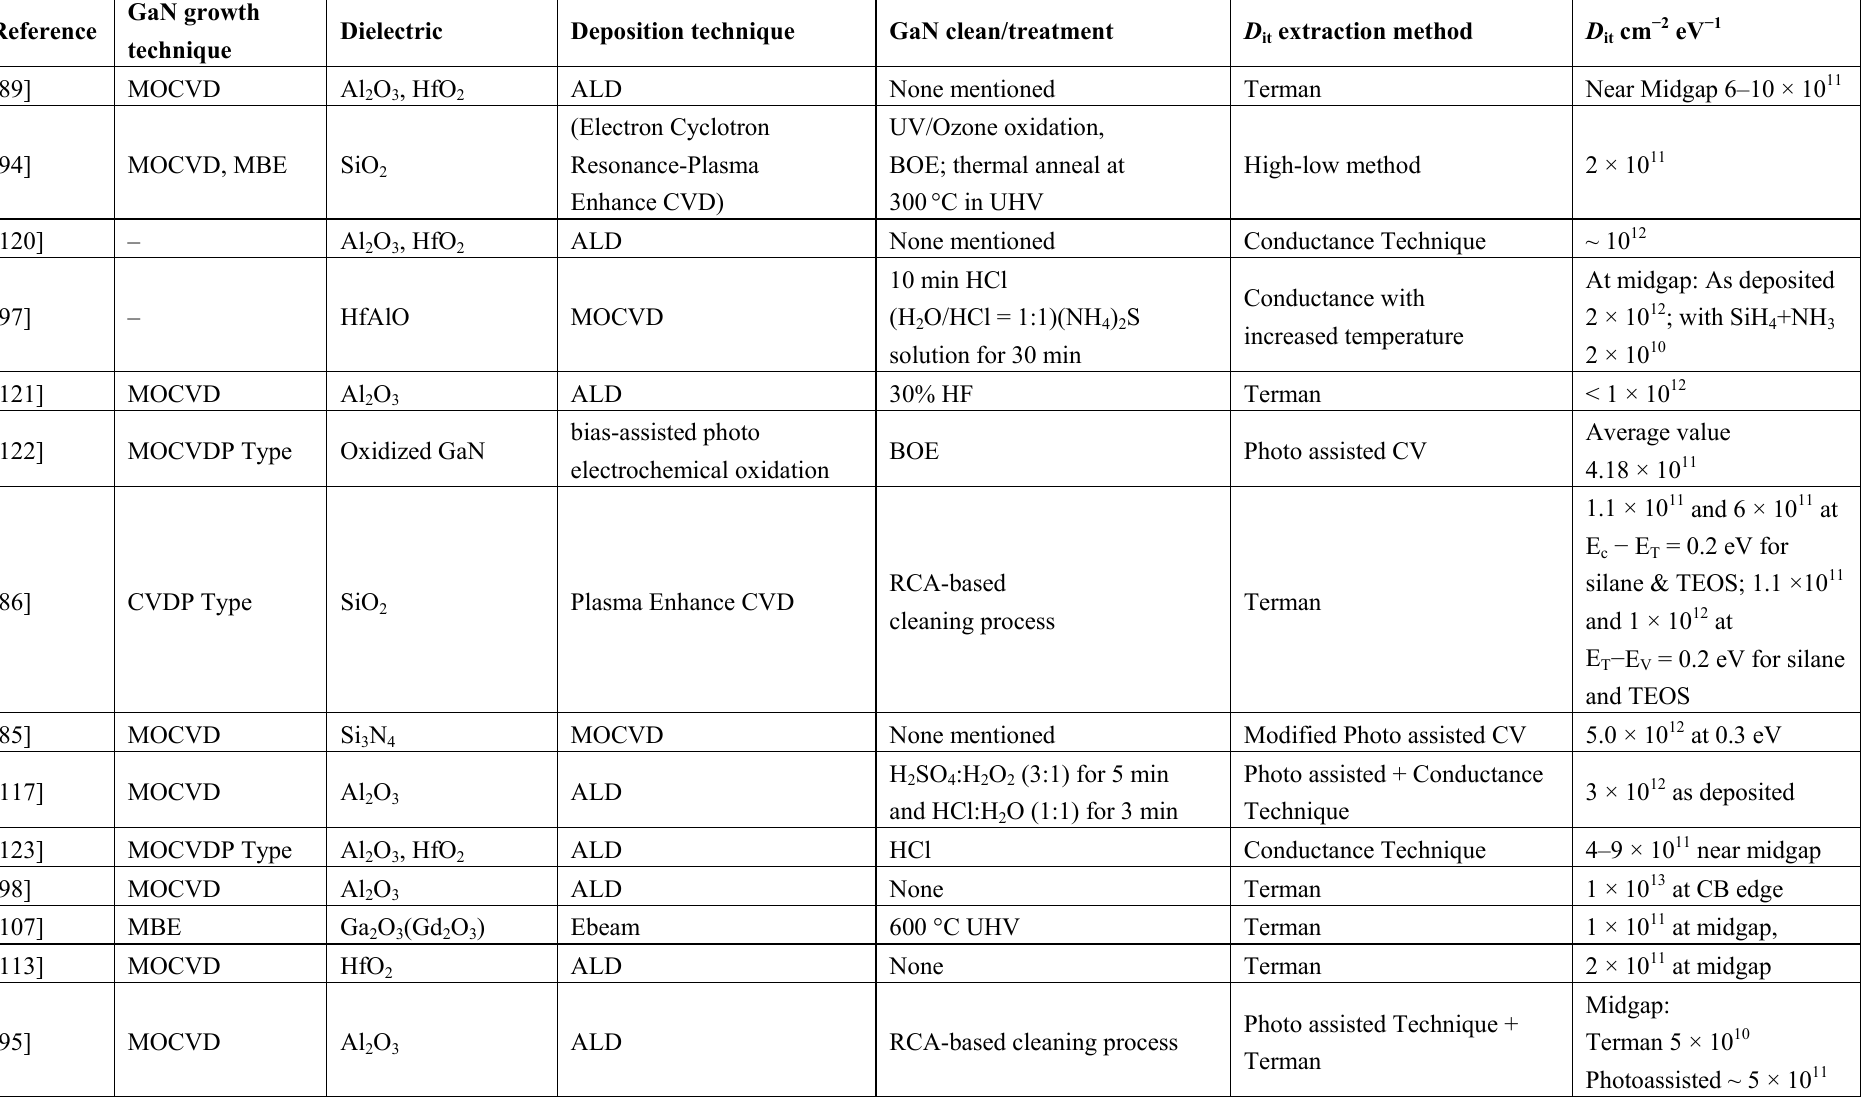
Table 3. Summary of relatively recent literature on the electrical characteristics of GaN MOS